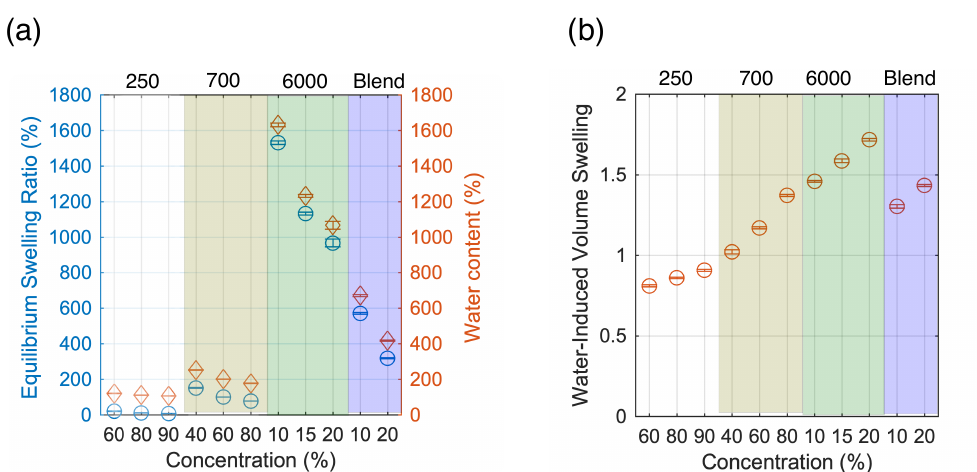
Figure 2. ( a ) Equilibrium swelling ratio and water content for different molecular weight and concentration; ( b ) Calculated water-induced volume swelling of polyethylene glycol diacrylate (PEGDA) for different concentration and molecular weight.